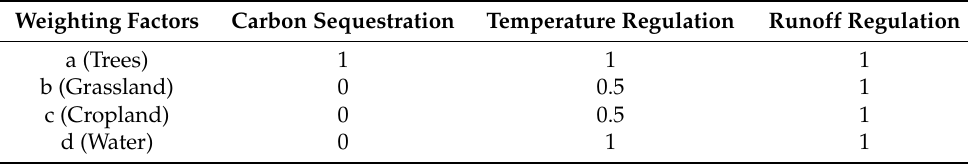
Table 1. The weighting factors (modified from Derkzen et al.